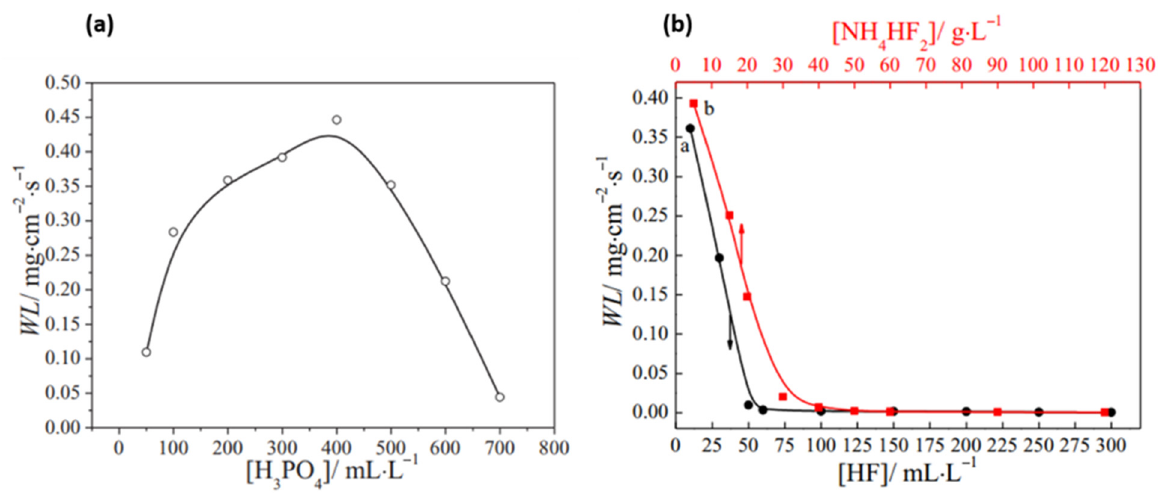
Figure 5. ( a ) The weight loss of an AZ31 Mg alloy immersed in H 3 PO 4 solution with different concentrations for 60 s [83]. ( b ) The weight loss of an AZ31 Mg alloy in aqueous solutions containing 400 mL/L H 3 PO 4 and different concentrations of HF/NH 4 HF 2 [83]. Reprinted from [83] with permission from IOP, respectively.